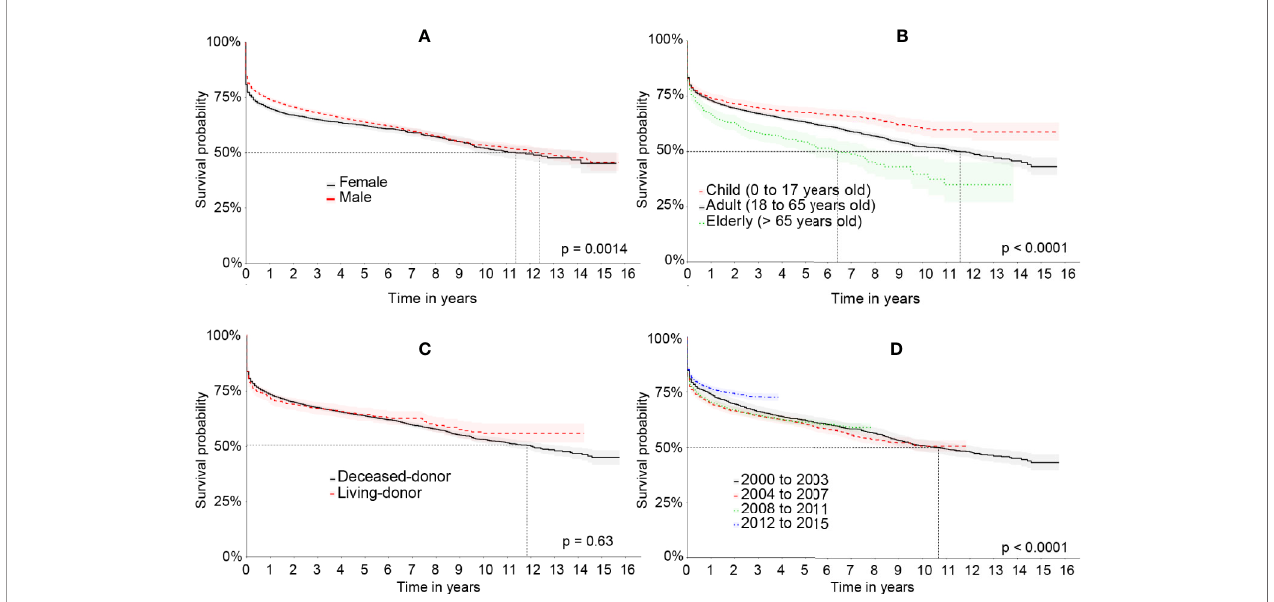
FIGURE 3 | Kaplan-Meier ’ s survival curve of the liver graft in the Full cohort comparing: (A) patient ’ s sex, (B) age group, (C) type of transplant, and (D) period of